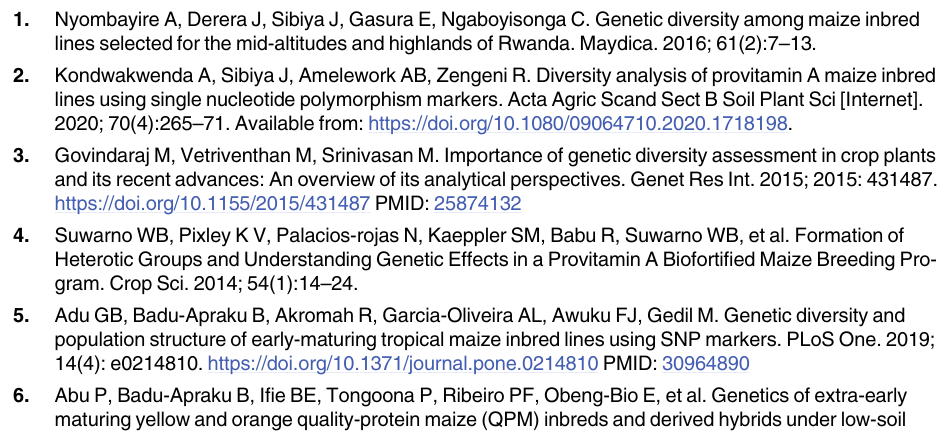
S3 Table. Grain yield and other agronomic traits of inbred lines under low nitrogen. S4 Table. Summary statistics of the 1691 markers used to assess the diversity. S5 Table. Pairwise genetic distances among the inbred lines used in the